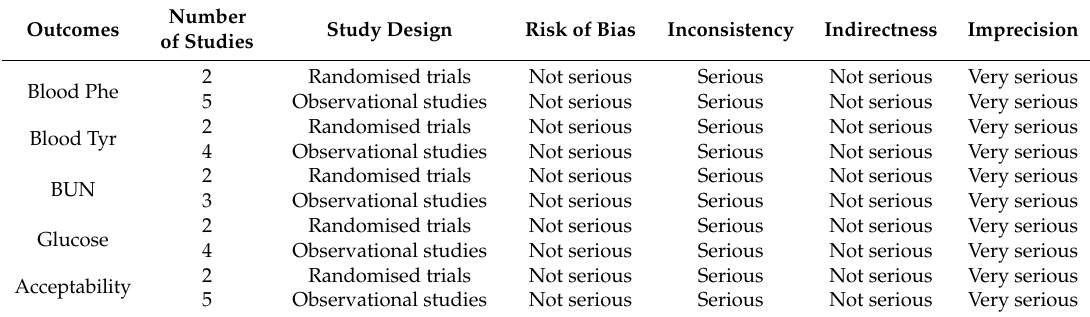
Table 4. Quality of all included studies according to Grading of Recommendations Assessment, Development and Evaluation (GRADE)